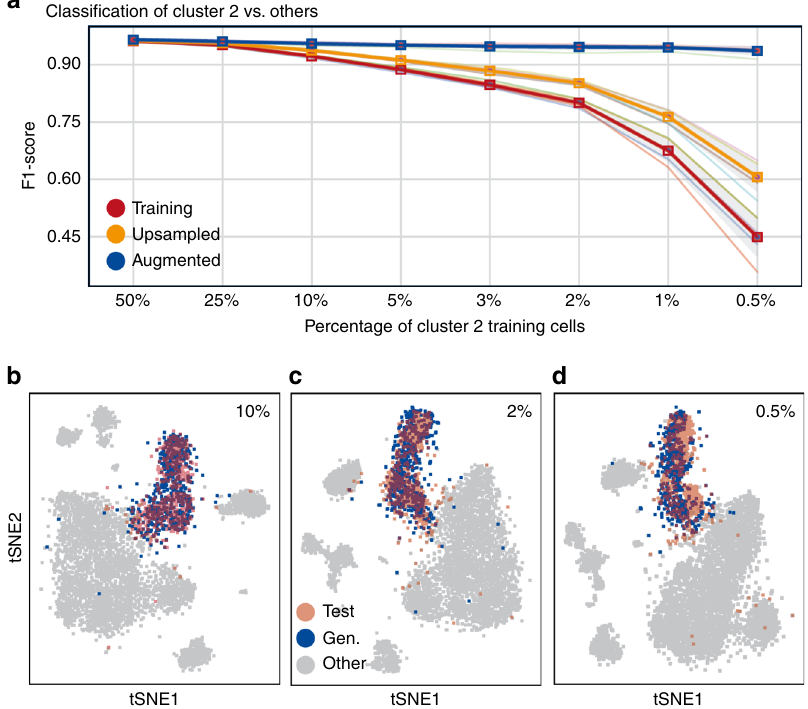
Fig. 3 Effects of data downsampling and augmentation on classi fi cation and clustering. a F1 score of an RF classi fi er trained to discriminate cluster 2 test from other test cells when trained on training (red), upsampled (orange), or augmented (blue) cells for eight levels of downsampling (50% to 0.5%). b – d t-SNE representation of cluster 2 real test (red) and cscGAN-generated (blue) cells for three levels of downsampling (10% panel b , 2% panel c , and 0.5% panel d ). Other test cells are shown in